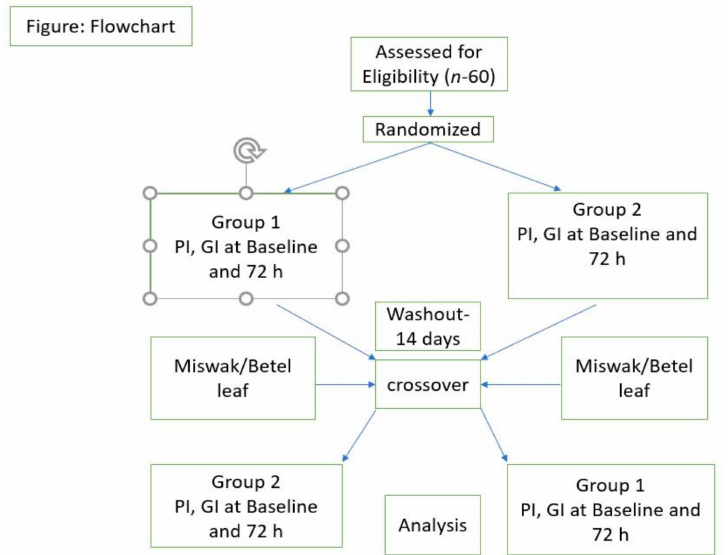
Figure 1. Flowchart. Selection, Randomization, and Analysis at different timepoints. PI—Plaque Index, GI—Gingival bleeding